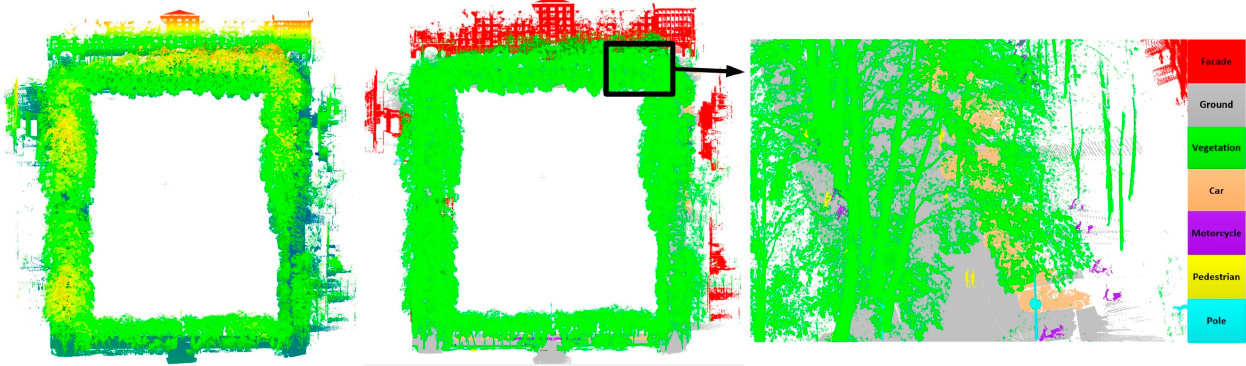
Figure 7. Details of the Wuhan University dataset.